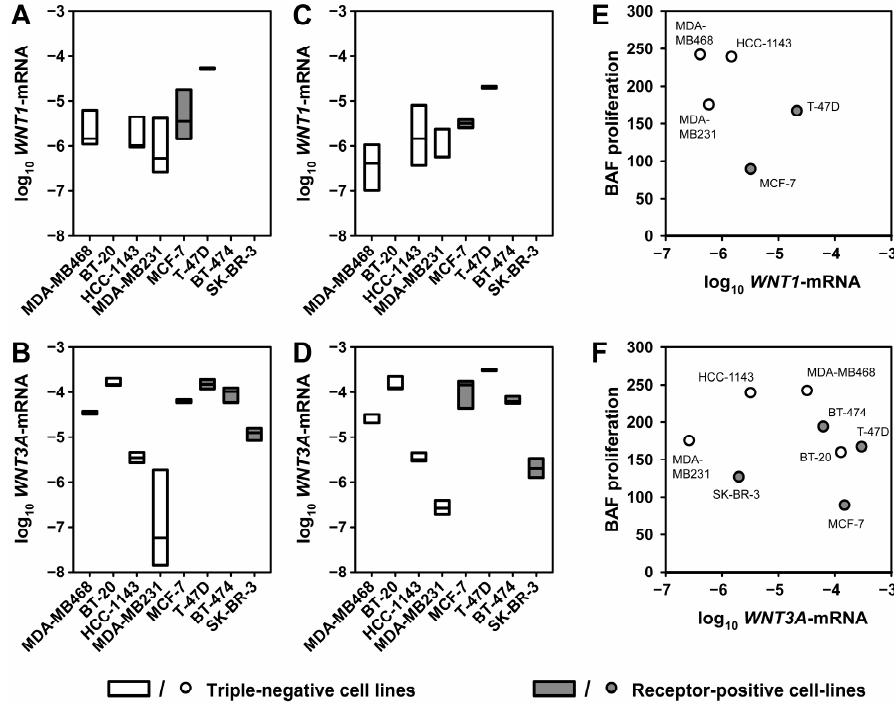
Figure A2. WNT1 and WNT3A expression in breast cancer cell lines. RNA was isolated from cells used for production of CM under FBS containing or serum-free conditions, respectively, for three days. Expression levels were quantified by qPCR and are normalized to GAPDH expression. ( A ) WNT1 and ( B ) WNT3A expression in the presence of FBS. ( C ) WNT1 and ( D ) WNT3A expression in the absence of serum. The boxes indicate median and range for three independent experiments, absence of box indicates lack of quantifiable expression. ( E ) WNT1 and ( F ) WNT3A expression in the absence of serum were correlated with the proliferation rates of BAFs treated with 30% CM (indicated as vital cells in Figure 1B).